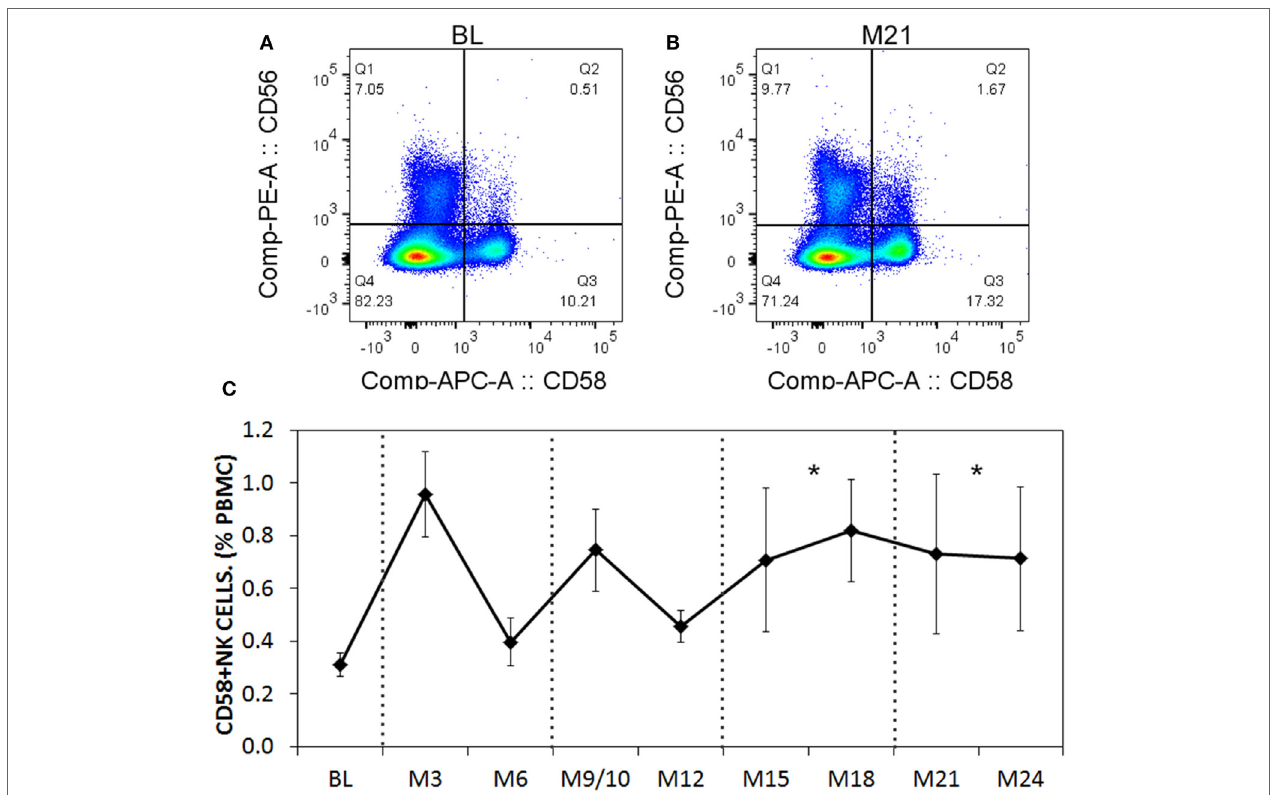
FigUre 10 | CD58 expression levels on natural killer (NK) cells before and after aHSCT treatment of multiple sclerosis (MS) patients. Cryopreserved peripheral blood mononuclear cell (PBMC) from the aHSCT cohort of MS patients was stained for CD3, CD56, and CD58. Representative plots for CD56 and CD58 are shown for baseline (BL) (a) and month 21 [M21; (B) ]. A time series of samples from BL until month 24 (M24) is presented (c) . For statistical analysis, the time points were grouped in M3–M6, M9–M12, M15–M18, and M21–M24, followed by univariate one-way ANOVA with pairwise comparisons with the BL values. N = 7